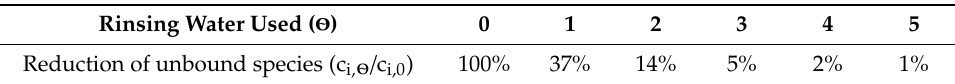
Figure 7. Rinsing of filtration circuit with water. Table 5. Reduction of unbound species in the filtration circuit by rinsing with water (calculated by Equation (2)).